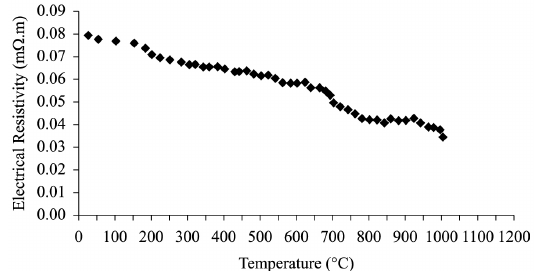
Figure 8. Measurements of electrical resistivity DC in situ of carbon fiber/phenolic resin composite during pyrolysis, at heating rate